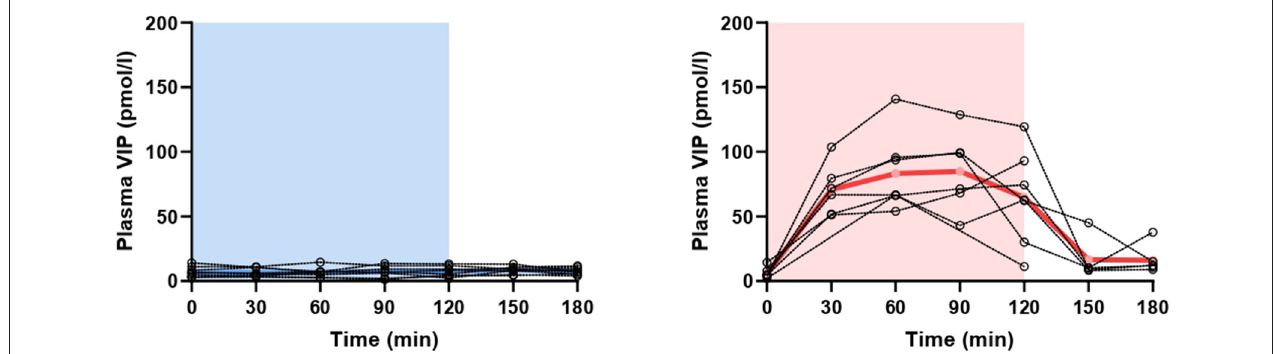
FIGURE 3 | Changes in plasma concentration of vasoactive intestinal polypeptide (VIP) during and after 2-h infusion of placebo ( p = 0.599) or VIP ( p < 0.001) in healthy individuals. The light blue area represents placebo infusion, while the red area represents VIP infusion. Dotted lines represent individual values, while thick lines show mean concentrations.